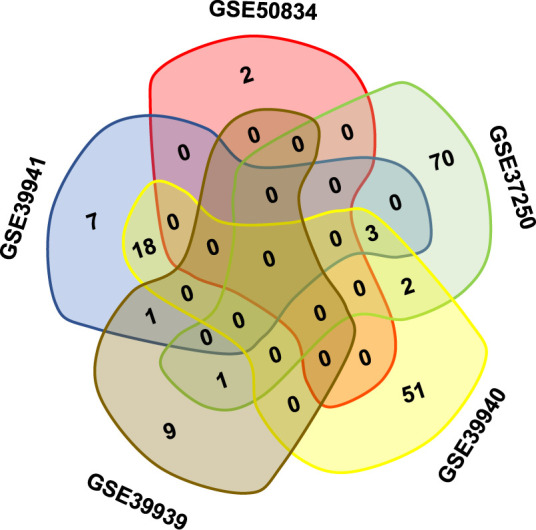
The overlapping DEGs in different studies on HIV positive patients with or without TB coinfection. Note that there was no gene present in all five datasets in the Venn diagram.